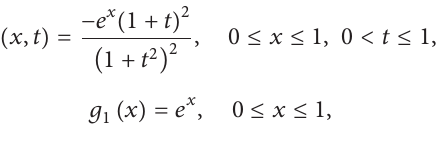
of numerical solutions at different time levels with known solution is presented graphically in the Figure 4.